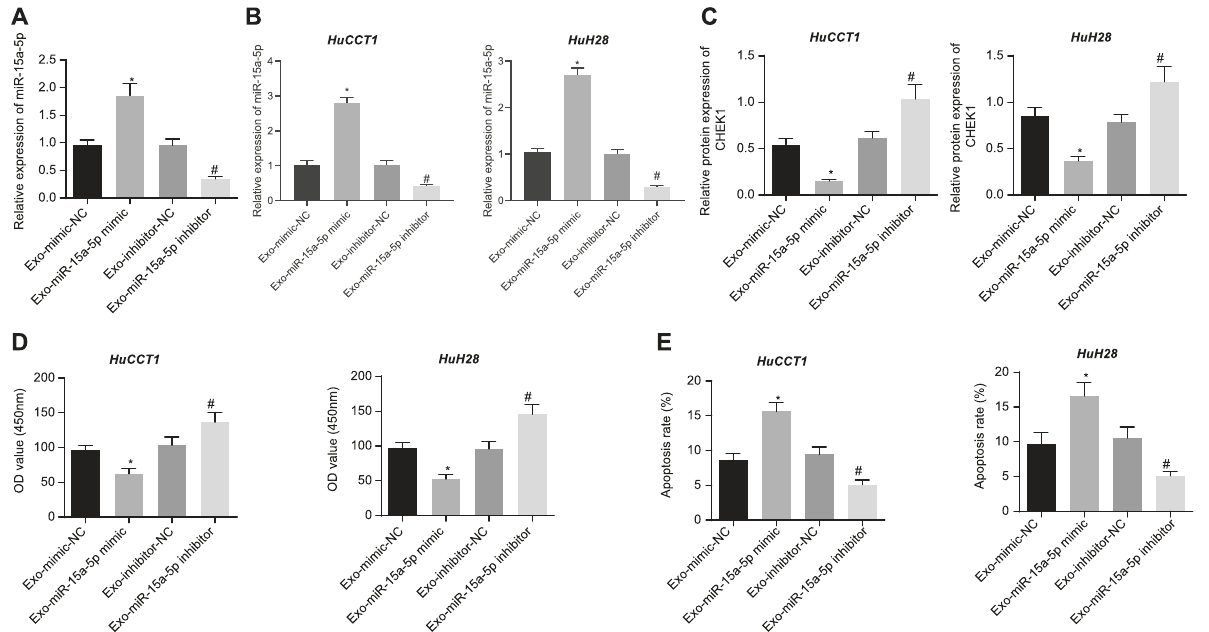
15a-5p mimic, inhibitor-NC, or miR-15a-5p inhibitor. B miR-15a-5p expression in HuCCT1 and HuH28 cells determined by RT-qPCR. C Western blot assay of CHEK1 protein in HuCCT1 and HuH28 cells. D Proliferative analysis of HuCCT1 and HuH28 cells. OD value was assessed at 450 nm. E Apoptosis evaluation of HuCCT1 and HuH28 cells using fl ow cytometry. B – E Exo-miR-15a-5p mimic or Exo-miR-15a-5p inhibitor was individually transfected into CCA cells. The values at multiple groups were compared using one-way ANOVA followed by Tukey ’ s